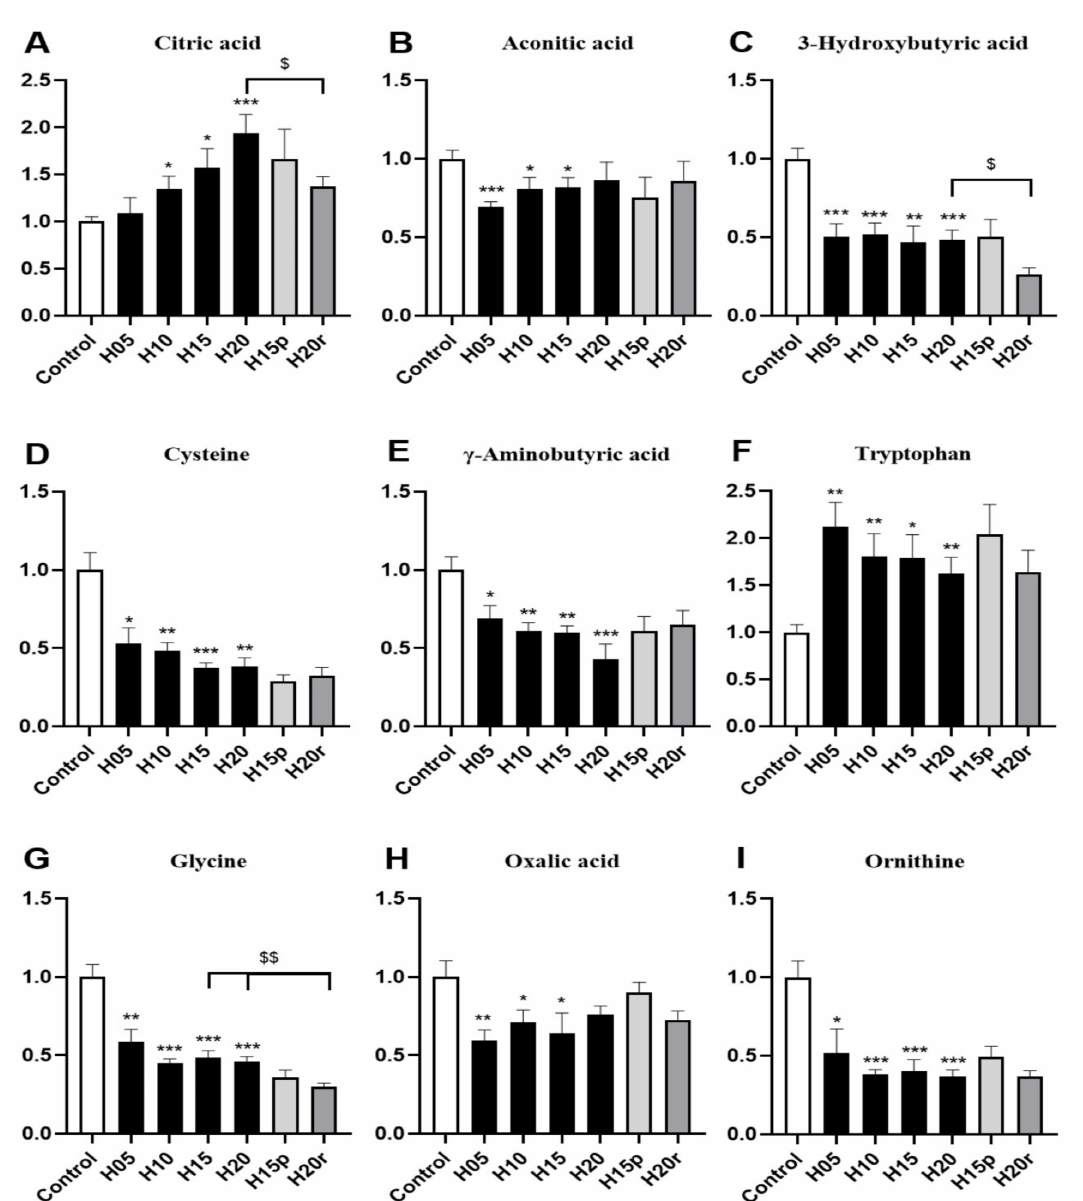
Figure 4. The effects of heroin on metabolites in urine. H5, exposure to heroin for 5 days; H10, exposure to heroin for 10 days; H15, exposure to heroin for 15 days; H20, exposure to heroin for 20 days; H15p, withdrawal for 5 days after 10 days of heroin administration; H20r, relapsing heroin use for 5 days (* p < 0.05, ** p < 0.01 and *** p < 0.001 compared with the con- trol groups; H15p compared with H15; H20r compared with H15 or H20, $ p < 0.05 and $$ p < 0.01. ( A ) Citric acid, ( B ) Aconotic acid, ( C ) 3-Hydroxybutyric acid, ( D ) Cysteine, ( E ) γ -Aminobutyrix acid, ( F ) Tryptophan, ( G ) Glycine, ( H ) Oxalic acid, ( I )